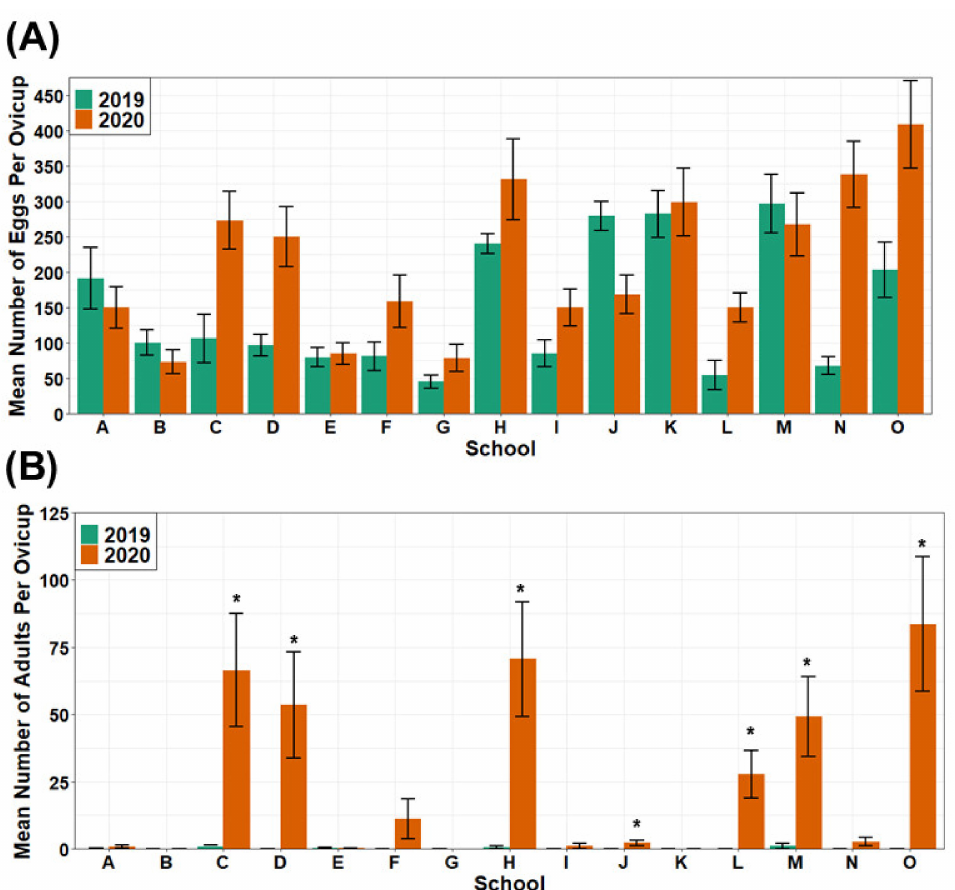
Figure 3. Mean number of eggs ( A ) collected by educators in 2019 and 2020 and average number of adults that emerged from those egg collections ( B ). * = educators stored their egg papers in plastic Tupperware containers in